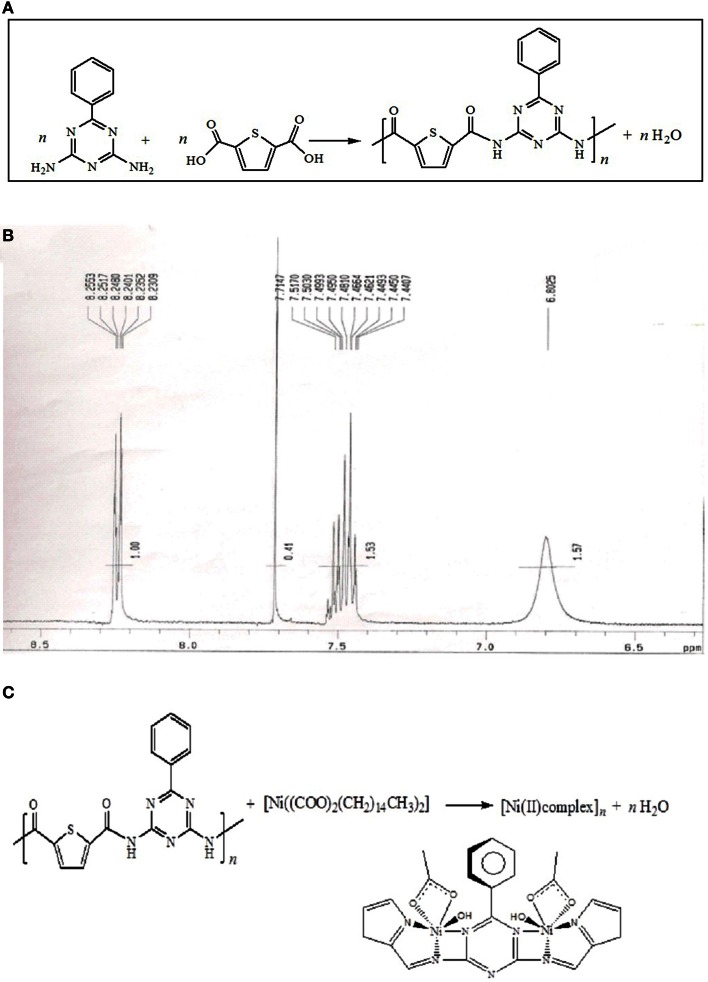
(A) The synthetic steps for the preparation of ligand. (B) The structural formula of L was ascertained from 1H-NMR and FTIR spectroscopies. The amide protons appear as a singlet at 7.71 ppm, and all aromatic protons appear as a multiplet in the range 7.44–7.51 ppm. (C) Ni (II) complex containing polymeric ligand was synthesized as a greenish precipitate in ethanolic solution owing to their low ethanol solubility. The complex is a dinuclear repeat unit and stable toward air and moisture. It is soluble in DMSO but insoluble in common organic solvents.